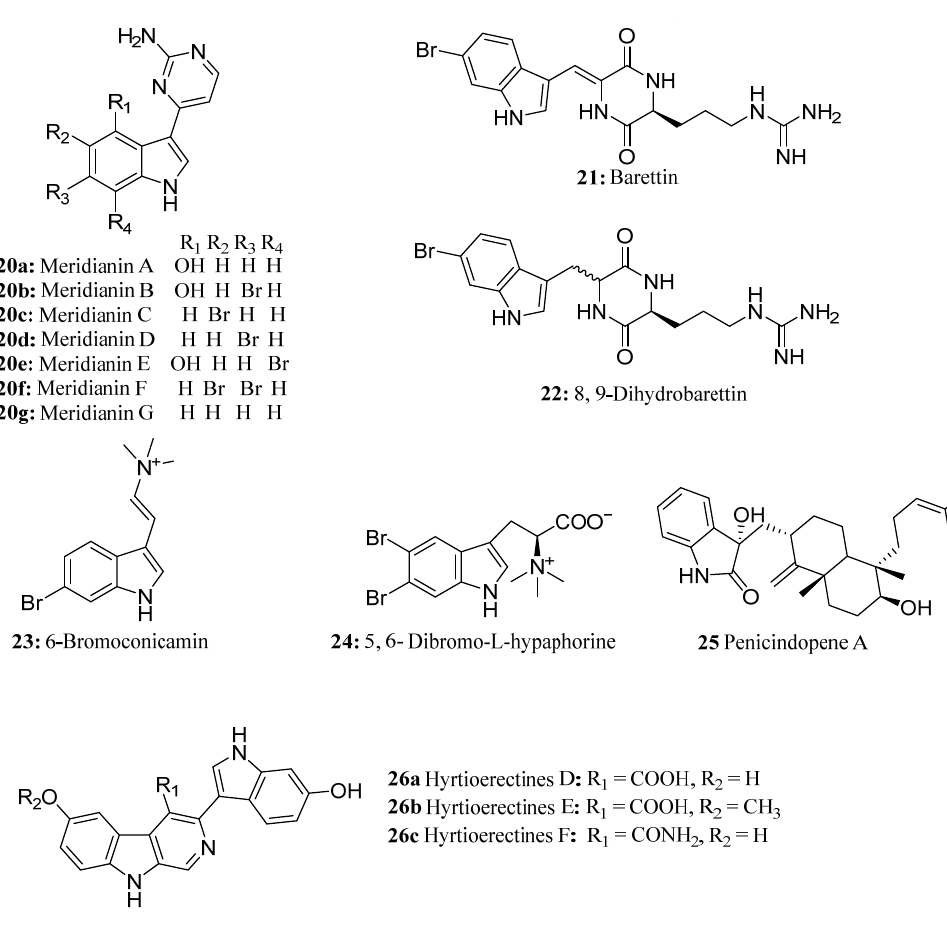
Figure 4. The structure of compounds 20a – 26c .